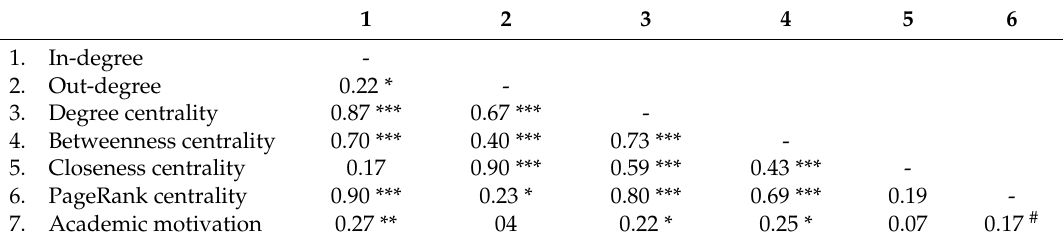
Table 1. Pearson’s correlation coefficients of the tested variables ( # p < 0.10, * p < 0.05, ** p < 0.01, *** p < 0.001), N = 94.